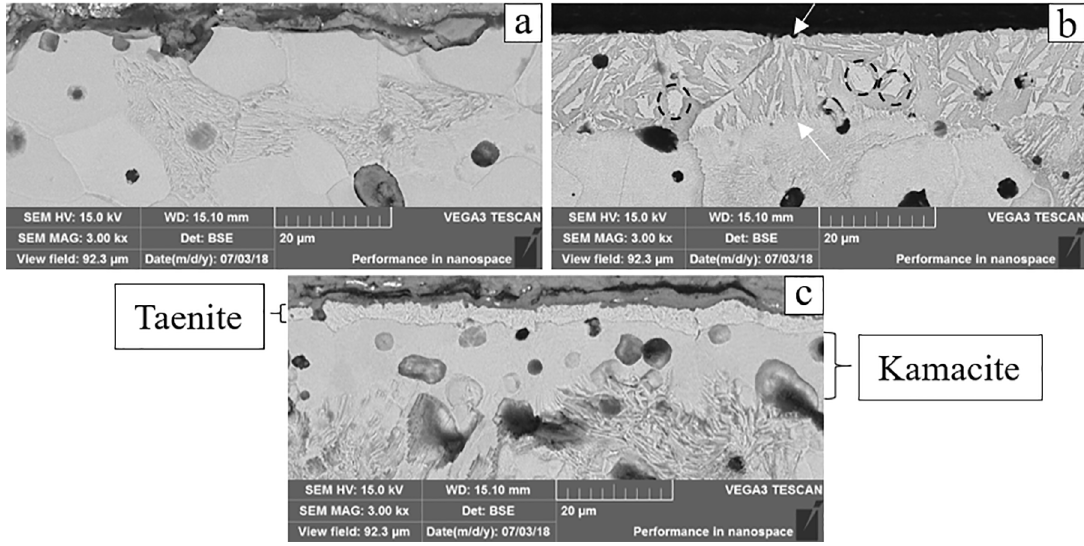
Figure 4. SEM imagens of cross section samples after chemical etching with Nital 2%: (a) the presents phases in S1 sample was ferrite, pearlite and graphite, (b) for the Mo2 sample was also observed bainite and fractions of martensite-austenite islands, and, (c) the Ni2.5 sample presented the taenite and kamacite phases, in addition to ferrite, pearlite and graphite.